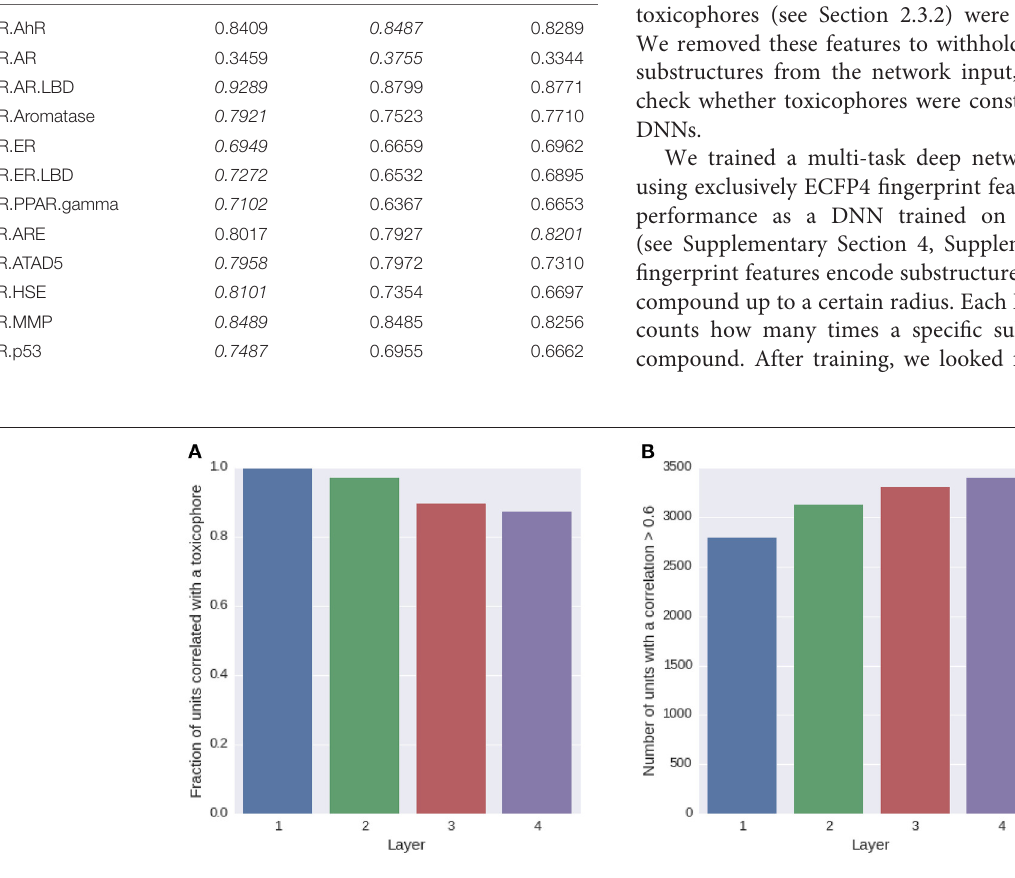
FIGURE 7 | Quantity of neurons with significant associations to toxicophores. (A) The histogram shows the fraction of neurons in a layer that yield significant correlations to a toxicophore. With an increasing level of the layer, the number of neurons with significant correlation decreases . (B) The histogram shows the number of neurons in a layer that exceed a correlation threshold of 0.6 to their best correlated toxicophore. Contrary to (A) the number of neurons increases with the network layer. Note that each layer consisted of the same number of neurons.